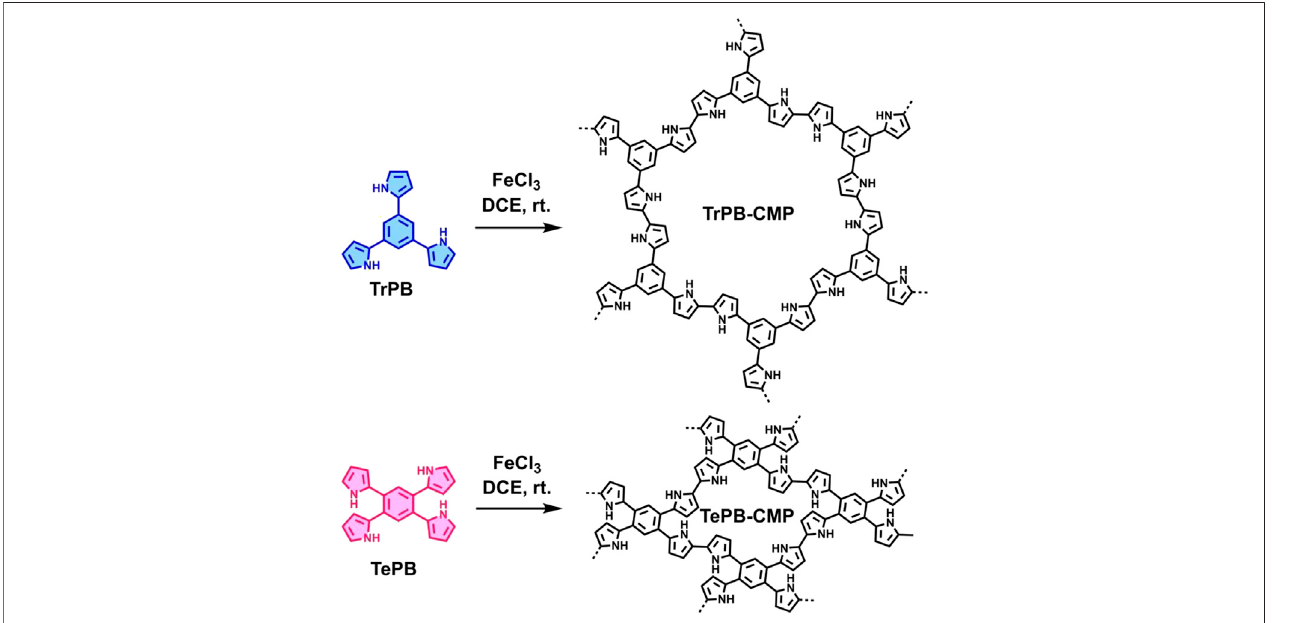
SCHEME 1 | Synthetic routes for TrPB-CMP and TePB-CMP.